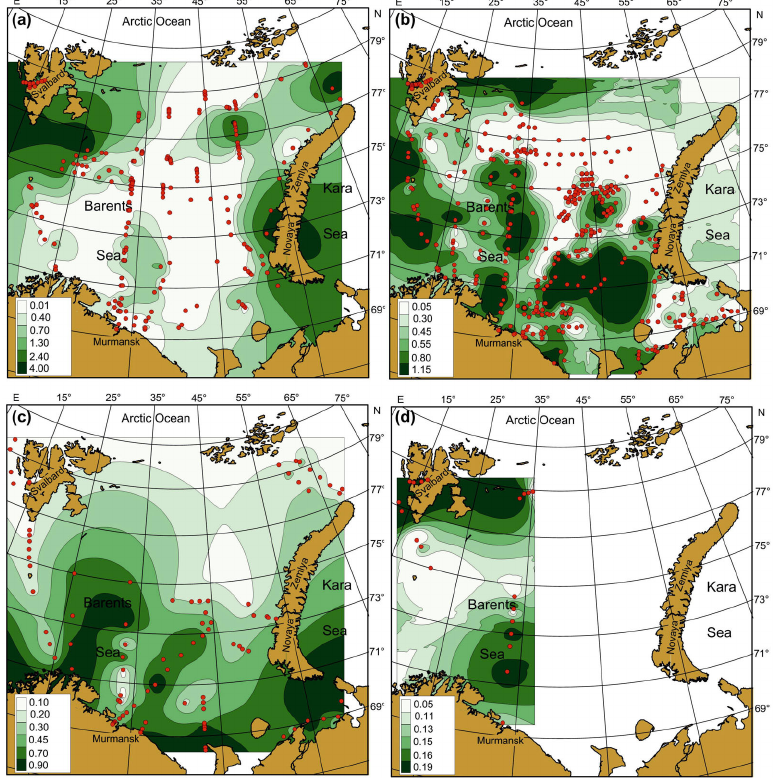
Figure 6. Averaged Chl ‐ a (mg m –3 ) in the Barents Sea, 1984–2021. ( a )—spring; ( b )—summer; ( c )—autumn; ( d )—winter. Points indicate the location of sampling stations. Table 2. Mean SST (°C), SSS (psu), and Chl ‐ a (mg m –3 ) in the Barents Sea, 1984–2021. Letters show significant differences between seasons (Tukey’s pairwise comparisons, p < 0.05).